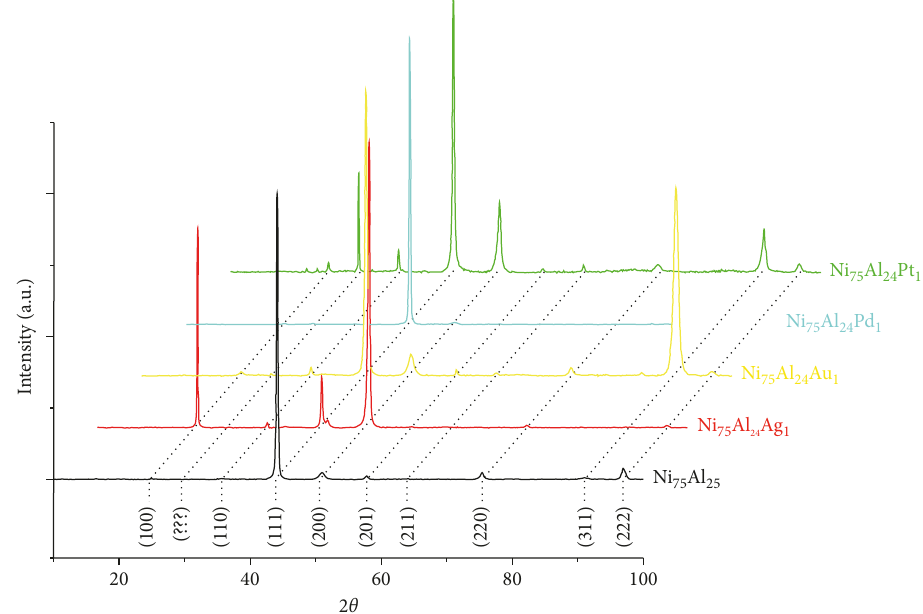
Figure 1: The XRD patterns of Ni 3 Al and Ni 3 Al doped with 1 at.% of noble